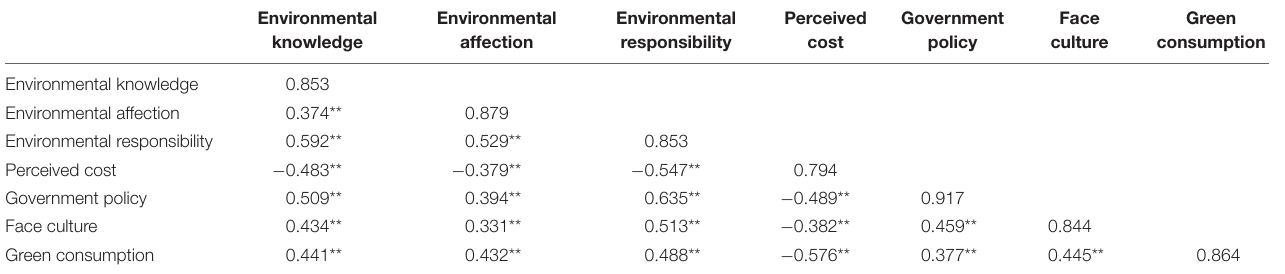
TABLE 2 | Discriminant validity test